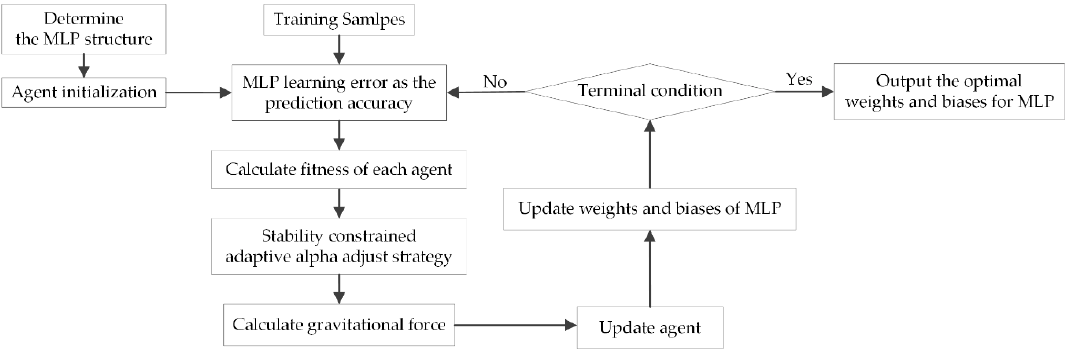
Figure 5. Flowchart of stability-constrained adaptive alpha (SCAA) optimizing MLP.